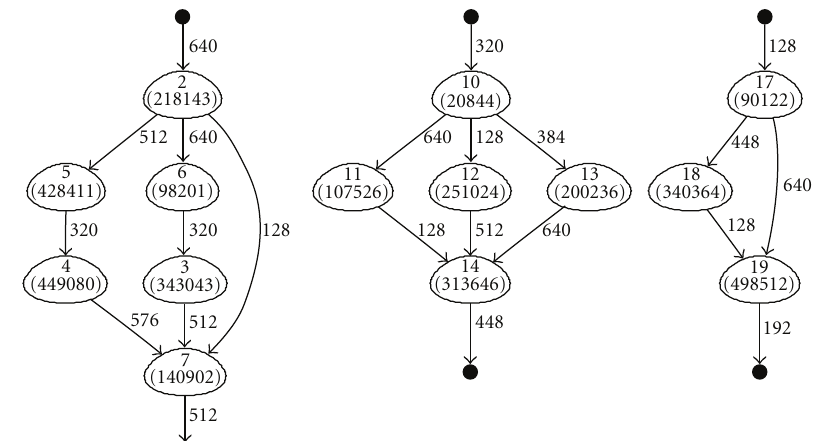
Figure 10: Example: generated task graph.